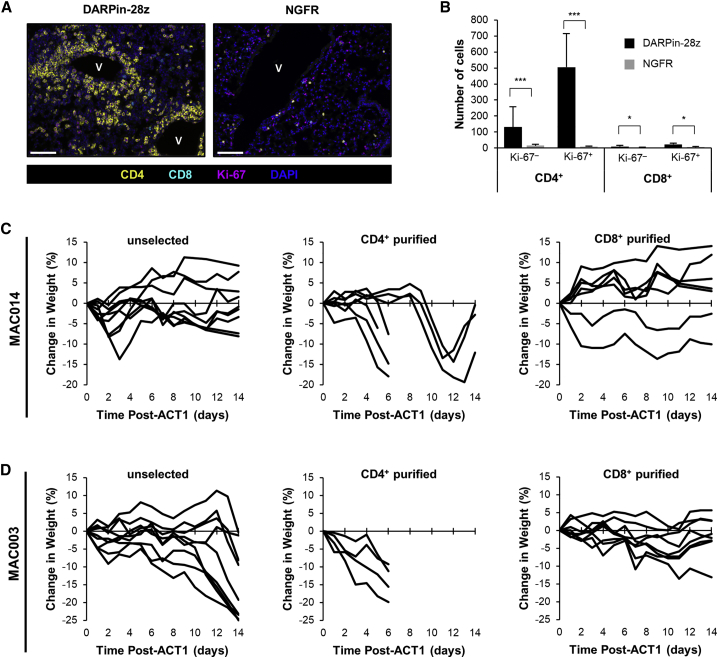
CD4+ DARPin-28z-T Cells Were the Primary Drivers of Toxicity(A) 7 days post-ACT1, FFPE lung tissues from DARPin-28z- or NGFR-T cell-treated mice (as described in Figure 2) were analyzed by multiplex immunofluorescence. Slides were stained for CD8 (cyan), CD4 (yellow), DNA (DAPI, blue) and a proliferation marker (Ki-67, magenta). Representative images are from 3 mice; n = 3 images per mouse (scale bars, 100 μm) are shown. (B) Quantification of the full dataset (error bars represent SD). (C and D) OVCAR-3 tumor-bearing or tumor-free NRG mice were treated with DARPin-28z-T cells generated from CD4+ purified, CD8+ purified, or unselected MAC014 PBMCs (C) (3.2 × 106–6.0 × 106 DARPin-28z-T cells per mouse) or MAC003 PBMCs (D) (6.0 × 106 DARPin-28z-T cells per mouse). Mice were followed for changes in weight; each line indicates data from one mouse; curves end, indicating when mice succumbed to toxicity.